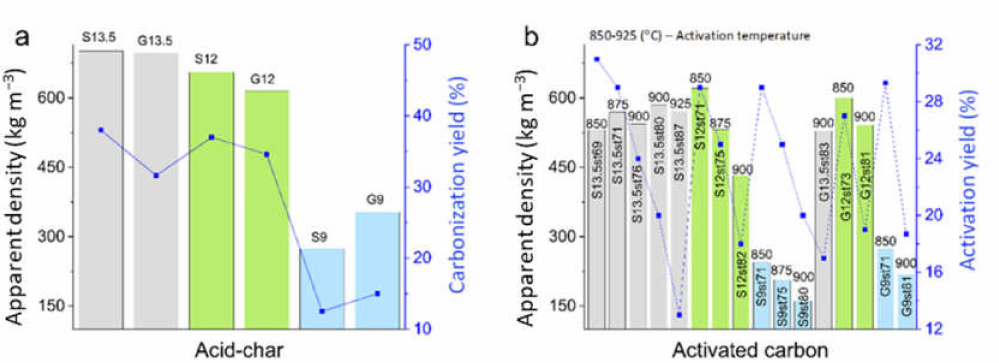
Figure 1. Influence of the synthesis conditions of acid-chars ( a ) and activated carbons ( b ) on, respec- tively, carbonization and activation yield, and apparent